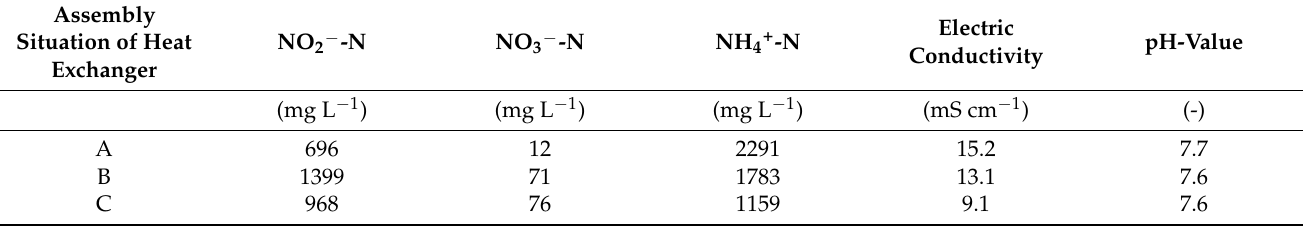
Table A2. Nitrite, nitrate and ammonium content as well as electric conductivity and pH of the scrubbing water.